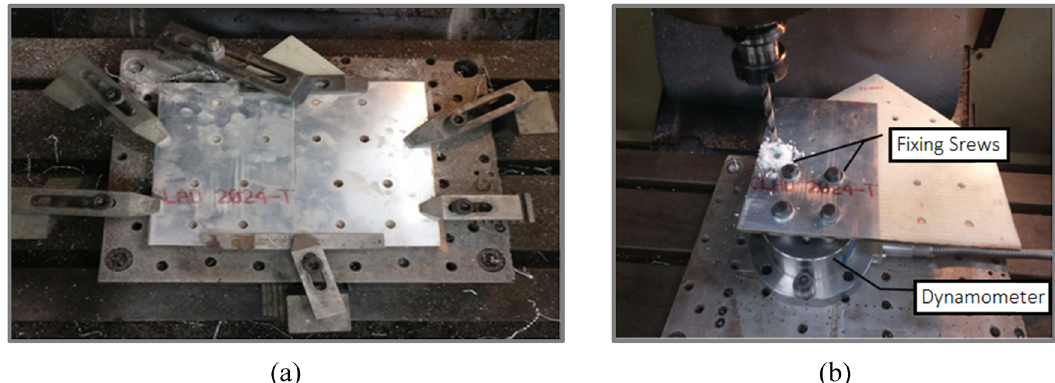
Figure 1: ( a ) Drill holes for fi xing the hybrid composite plate and ( b ) experimental setup.